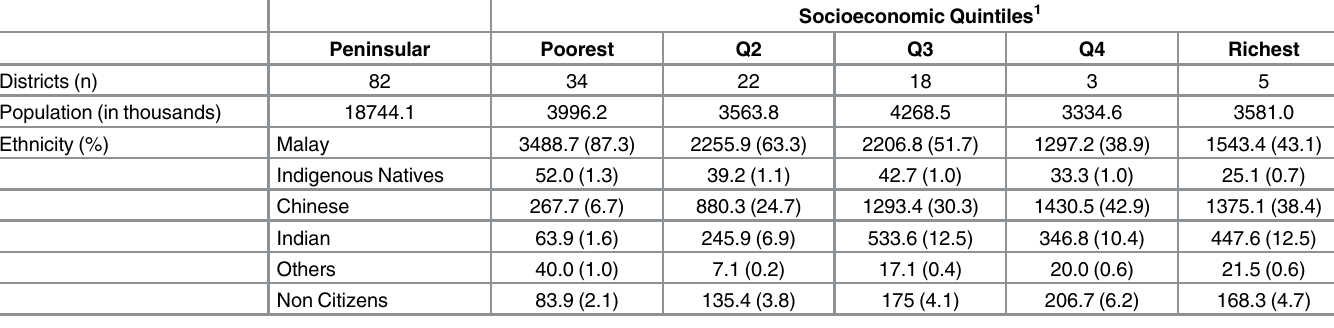
Table 2. District, Population Totals and Ethnic Groups by Socioeconomic Quintiles.